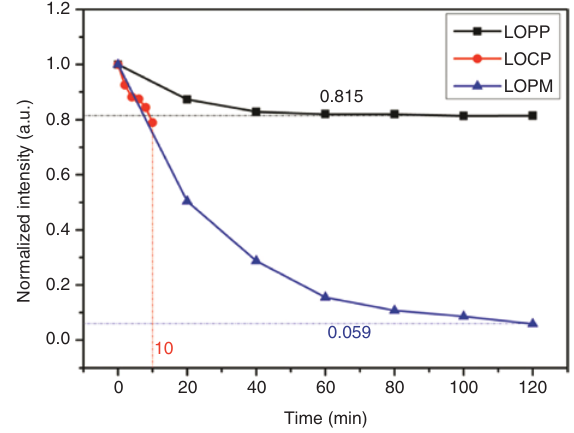
Figure 10: The normalized intensity of the main peak versus pump times for LOPP and LOPM.